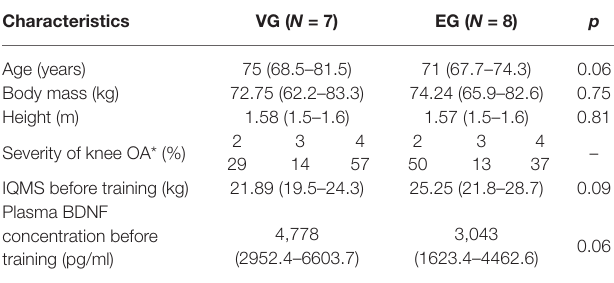
TABLE 1 | Sample characterization before training.